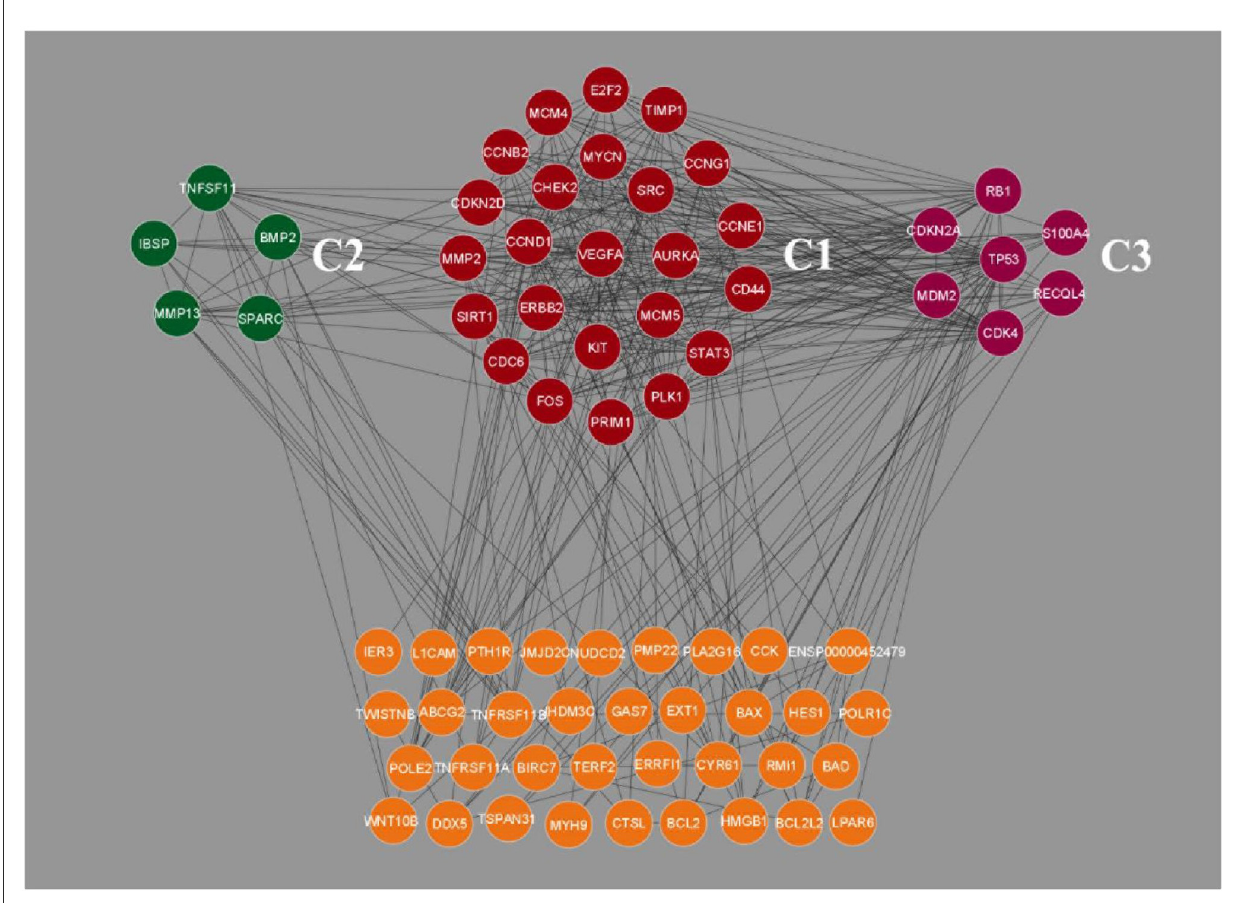
FIGURE2 Clustering analysis of Osteosarcoma gene interaction network using MCODE. The genes were grouped into three clusters, viz. C1, C2 and C3. Cluster C1 showed the highest level of clustering, followed by C2 and C3. The unclustered genes are located beneath, highlighted in orange color.